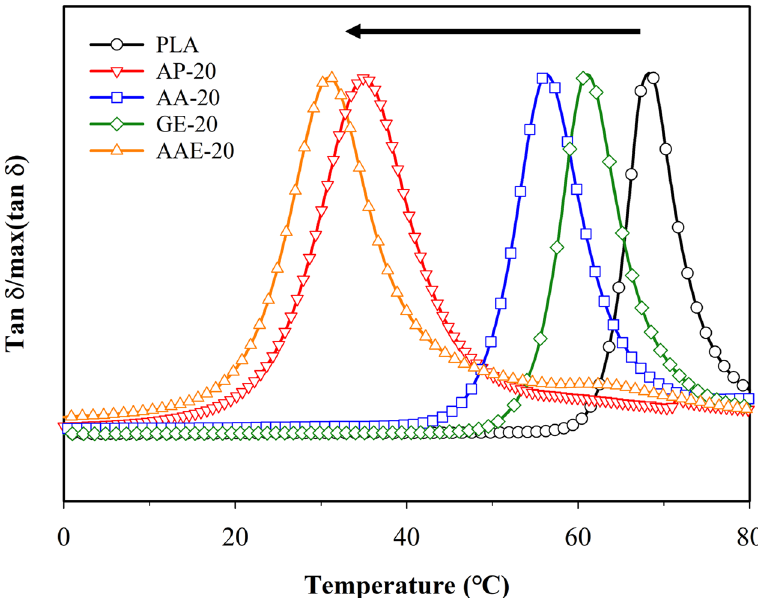
Figure 3. Variation of tan δ with temperature for neat PLA and PLA plasticized with varying plasticizer types and 20 phr.